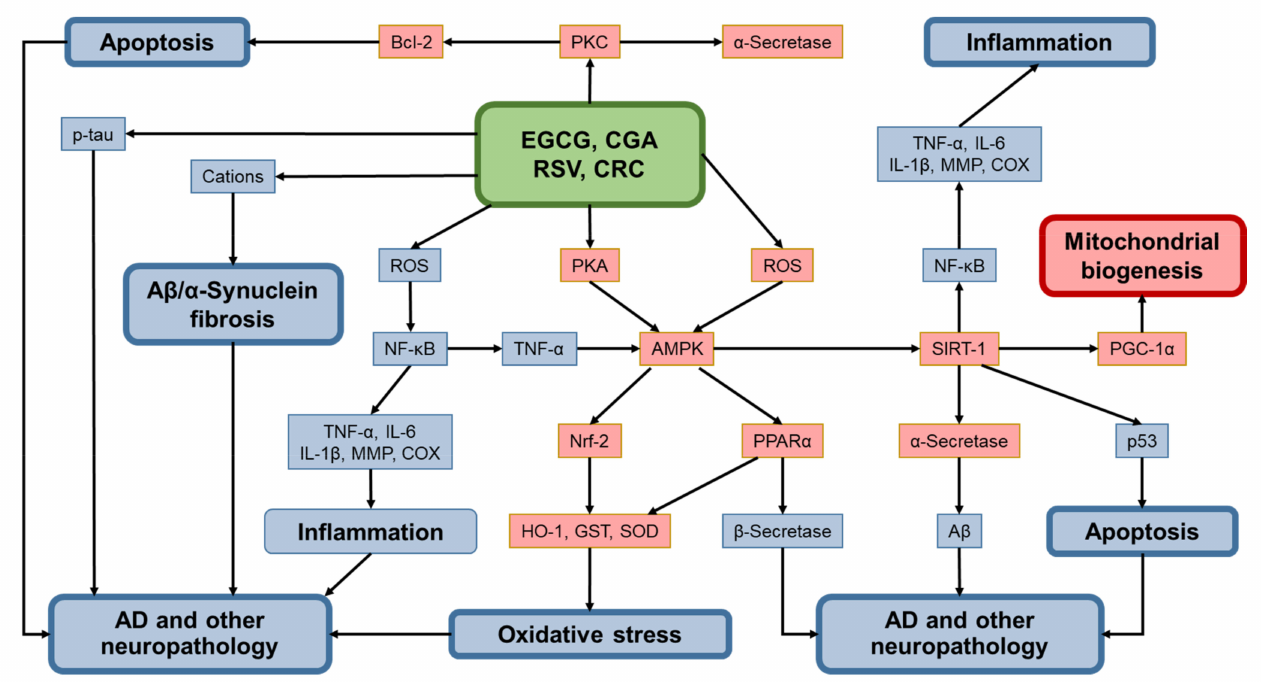
Figure 2. A putative mechanism under which EGCG, CGA, RSV, CRC exert anti-DDs effects. Red-colored boxes represent upregulation/stimulation and blue ones represent